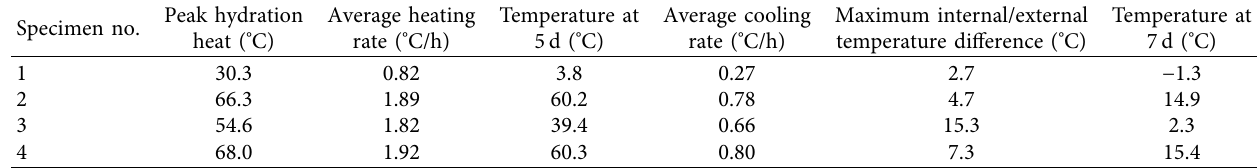
Figure 5: Temperature field measurements during hydration for (a) specimen 1, (b) specimen 2, (c) specimen 3, and (d) specimen Table 3: Key concrete temperature data at core measurement location T3.